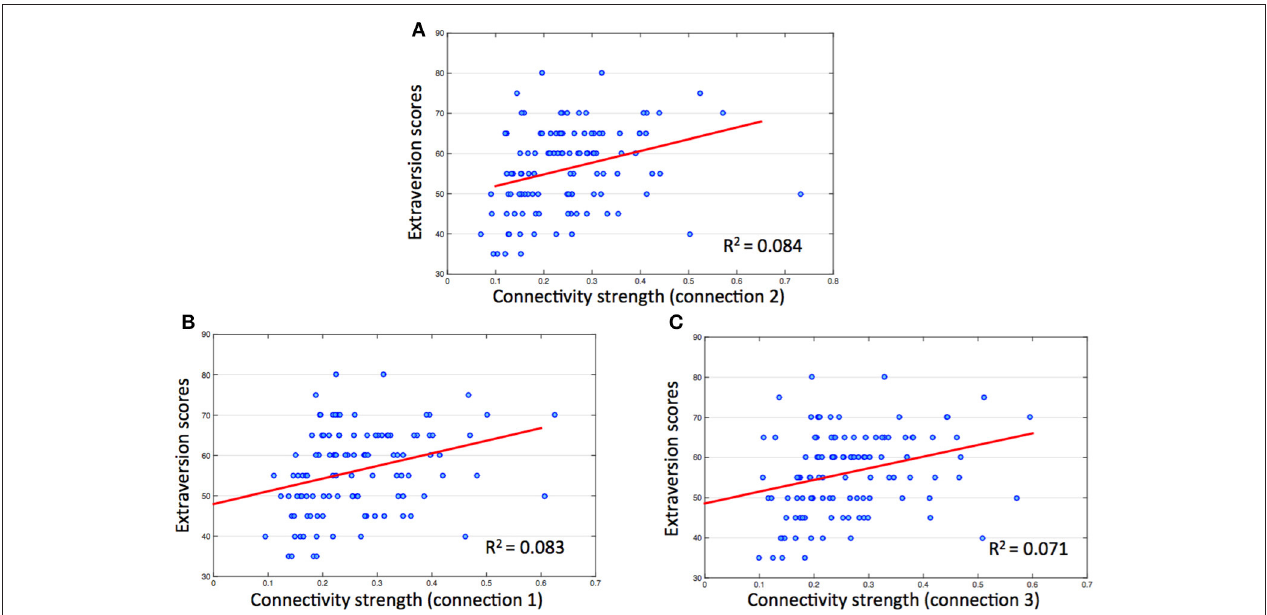
FIGURE 3 | Correlations between extraversion scores and connectivity strength in salience network. The numbers on the y, x coordinate indicate extraversion scores and connectivity strength (Fisher’s Z) between each ROI of salience network. (A) Connection 2 (between ACC and right insula), r = 0.304, p < 0.01; (B) connection 1 (between ACC and left insula), r = 0.302, p < 0.01; (C) connection 3 (between bilateral insula), r = 0.282, p < 0.01.